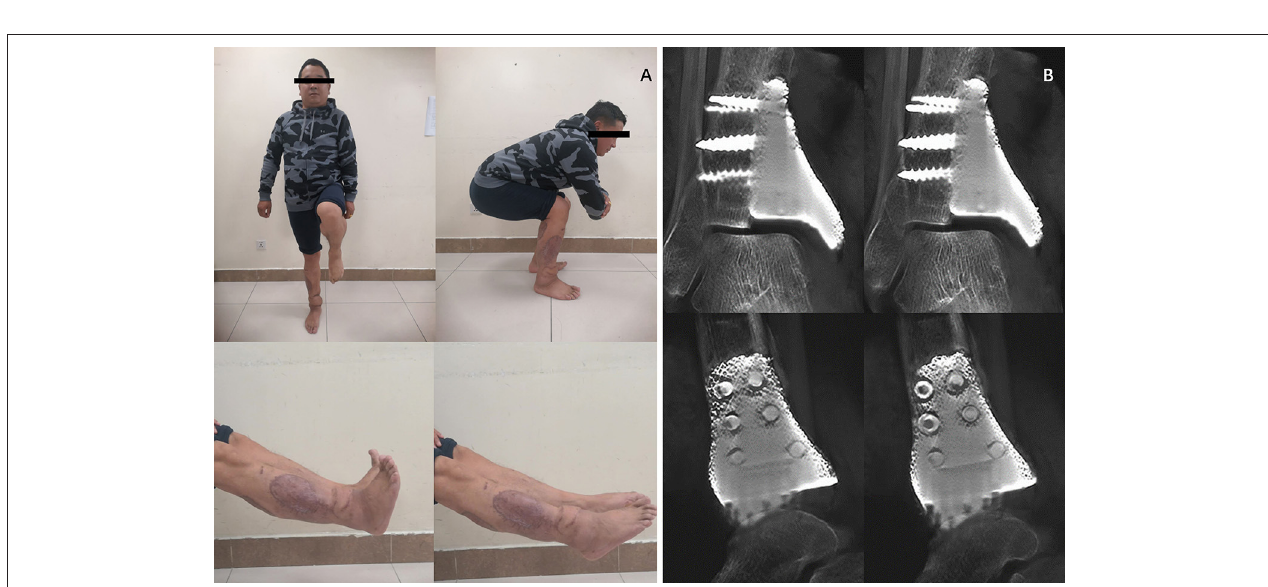
FIGURE 4 | (A) Digital tomosynthesis showed that the 3D prosthesis tightly integrated with the ankle joint, and partial bone substance could be observed to grow into the porous of the prosthesis. (B) Recovery of skin flap and functional outcomes of the ankle joint 7 months after surgery.